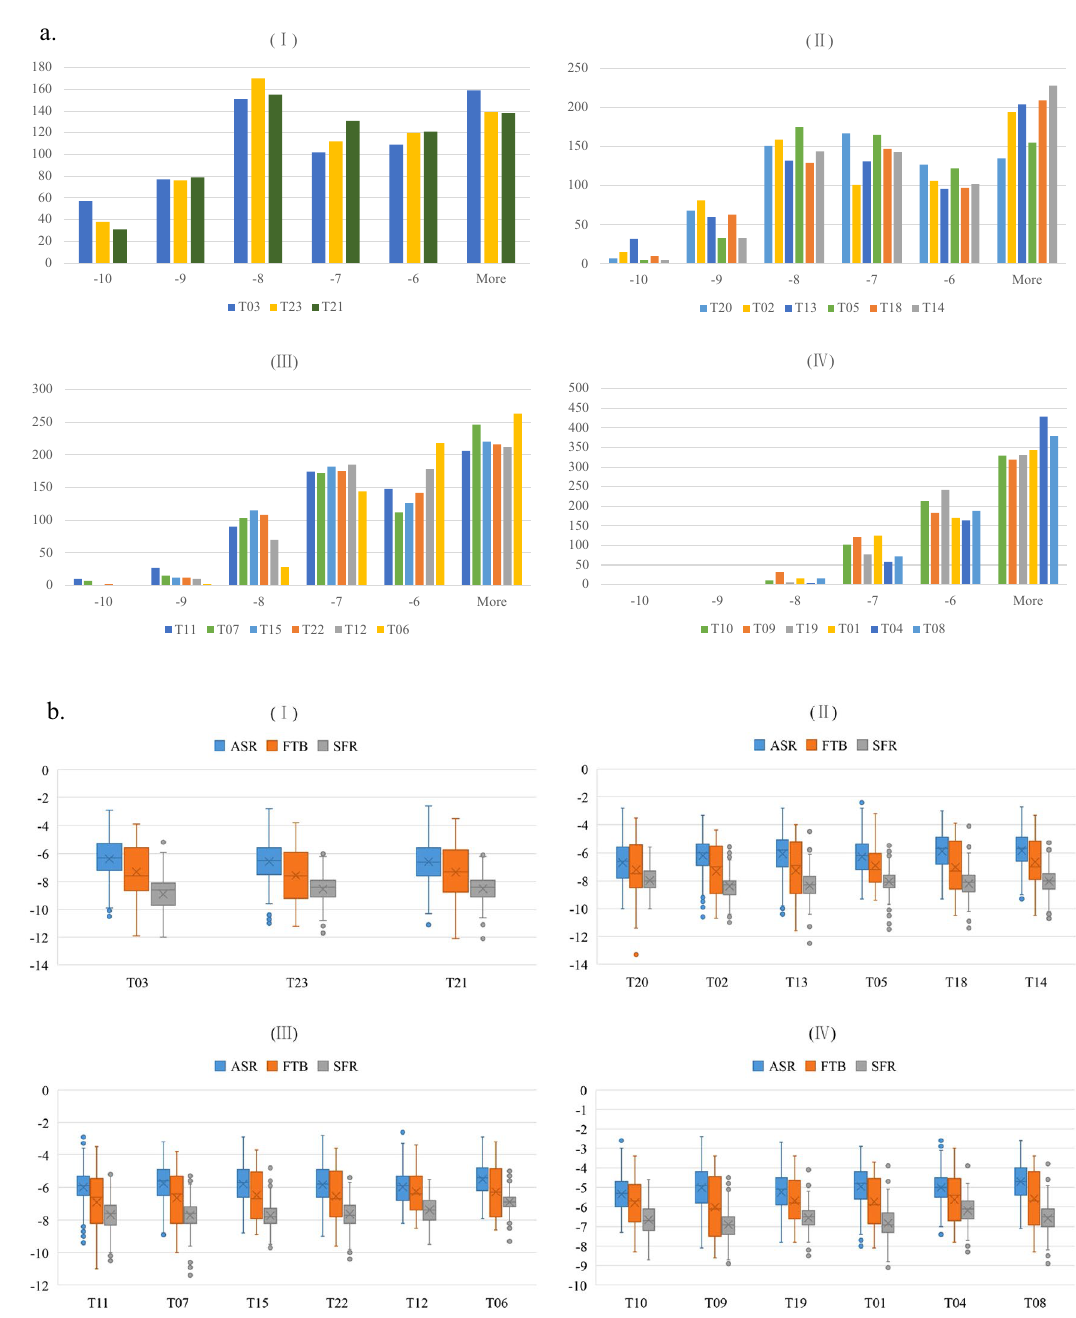
Figure 2. Binding patterns of all compounds against 21 targets. ( a ) Histograms of all compounds against 21 targets; ( b ) boxplots of all compounds from individual herbs of Danggui Beimu Kushen Wan against 21 targets. For Fig. 4a, x-axes stand for the predicted binding affinity values and y-axes stand for total number of ligands. For Fig. 4b, x-axes stand for the target proteins and y-axes represent the binding affinity for the compounds from each herb. ASR Angelicae Sinensis Radix, FTB Fritillariae Thunbergii Bulbus, SFR Sophorae Flavescentis Radix. (I): Top 1–3 targets; (II): Top 4–9 targets; (III): Top 10–15 targets; (IV): Top 16–21 targets; sequence was ranked by total binding scores. Corresponding target names refer to Table